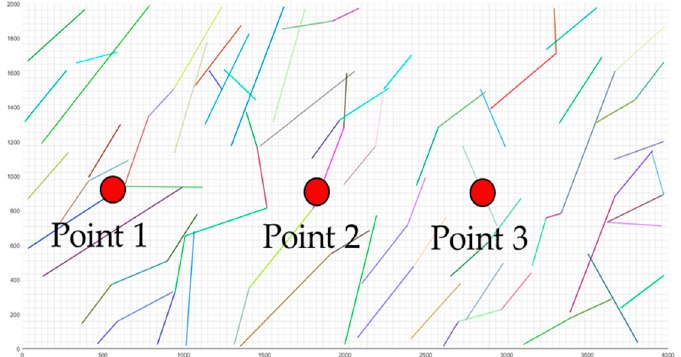
Figure 8. We set three starting coordinates of the well location: the starting coordinate of the first well location was (600,900), the starting coordinate of the second well location is (1800,900), and the starting coordinate of the third well location is (2850,900).